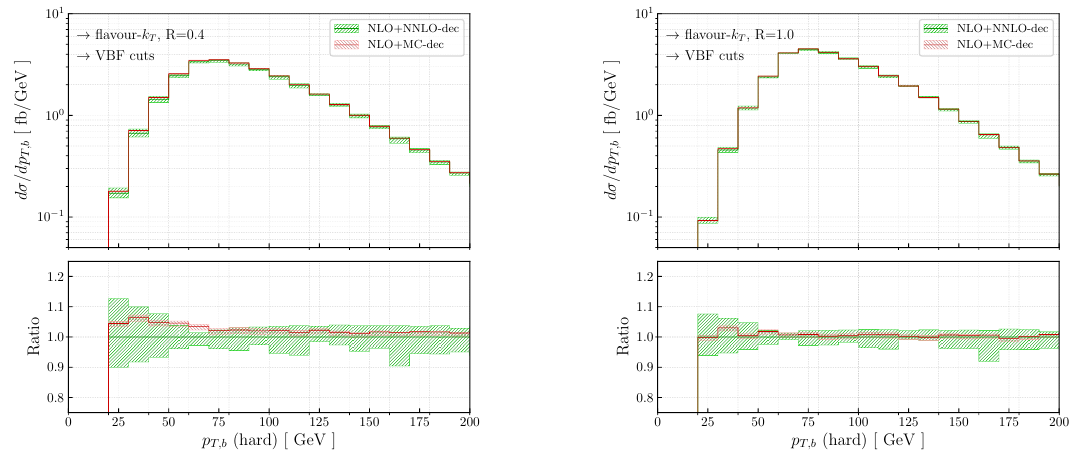
Figure 7 . Transverse momentum of the hardest b -jet in VBF Higgs events with Higgs decaying to b -quarks. The VBF cuts described in the text are applied. The jets are reconstructed with the (cid:13)avour algorithm of ref. [52] for R = 0 : 4 (left) and R = 1 : 0